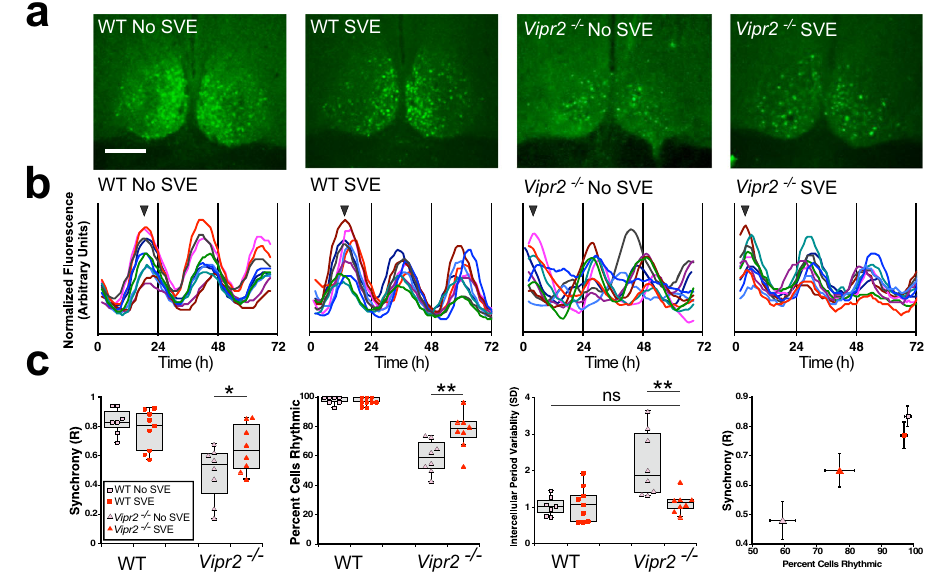
Fig. 3 SVE signi fi cantly improves Vipr2 − / − SCN temporal architecture. a Photomicrographs of WT and Vipr2 − / − SCN tissue from non-SVE and SVE mice expressing mPer1 :: d2eGFP fl uorescence, resolved to the single-cell level (scale bar: 200 µ m). b Example rhythm pro fi les show 10 cells each from single bilateral SCN recordings of mPer1 :: d2eGFP fl uorescence. Arrowheads in b indicate phase of images shown in a . c SVE signi fi cantly increased the synchrony (Rayleigh R increased to 0.65 ± 0.06 from 0.48 ± 0.07 (mean ± SEM); p = 0.039) and rhythmicity (77 ± 5% vs. 59 ± 4%; p = 0.001) and reduced the intercellular variability (SD of intercellular periods reduced to 1.1 ± 0.1 from 2.2 ± 0.3; p = 0.001) of rhythms resolved at the single-cell level in Vipr2 − / − SCN-containing brain slices. Correlation plot ( c , far right panel) illustrates the relationship between cellular synchrony and percentage of cells rhythmic across SCNs from both genotypes and experimental conditions. * p < 0.05; ** p < 0.01. WT non-SVE: 210 cells from 7 slices; WT SVE SCN: 270 cells from 9 slices; non-SVE Vipr2 − / − SCN: 190 cells, 8 slices; post-SVE Vipr2 : − / − 210 cells, 8 slices. Gray shaded boxes represent the interquartile distance between the upper and lower quartile with the median plotted as a horizontal line within the box. Whiskers in c depict the lower quartile − 1.5 × interquartile distance and upper quartile + 1.5 × interquartile distance. Individual data points overlaid. Also see Fig.